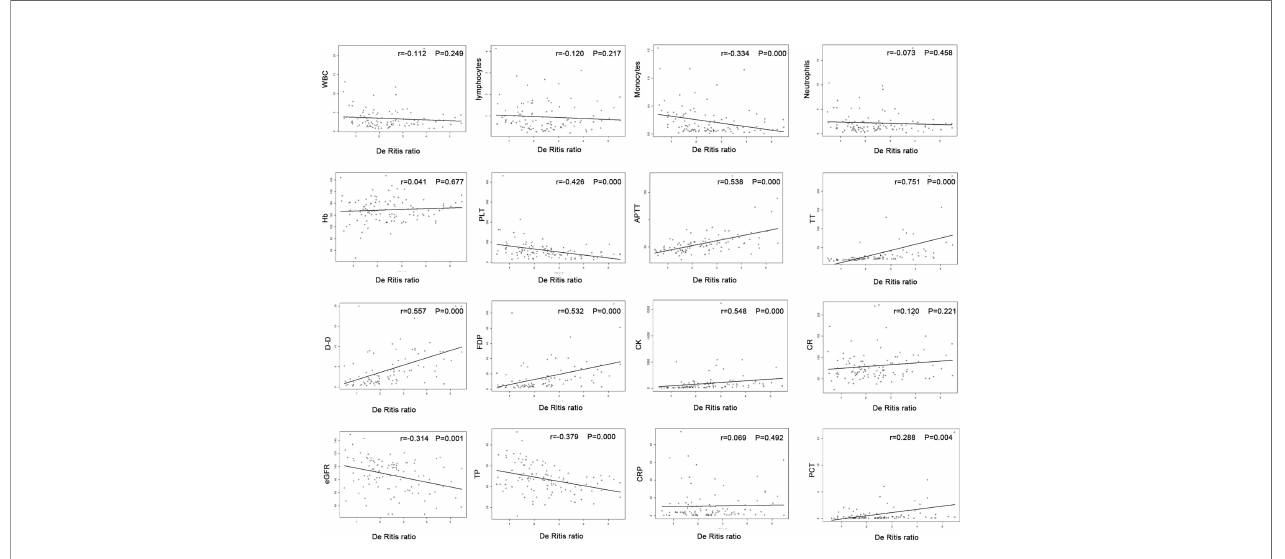
FIGURE 3 | Pairwise correlation between the De Ritis ratio and clinical parameters.